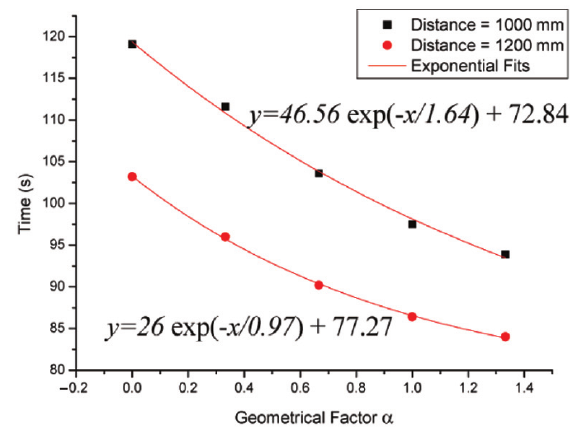
Fig. 6. Time needed for flame to propagate certain distances as a function of geometrical factor (The detailed fitting info is listed in Table 1)